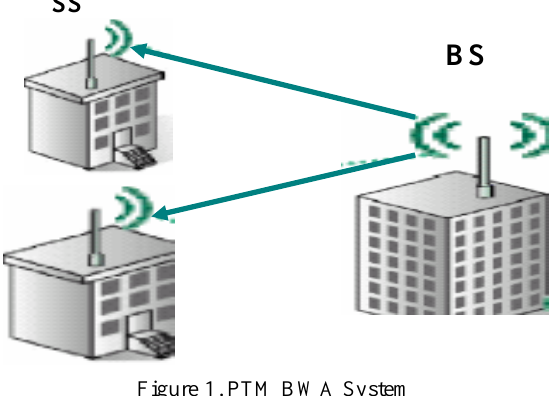
Figure 1. PTM BWA